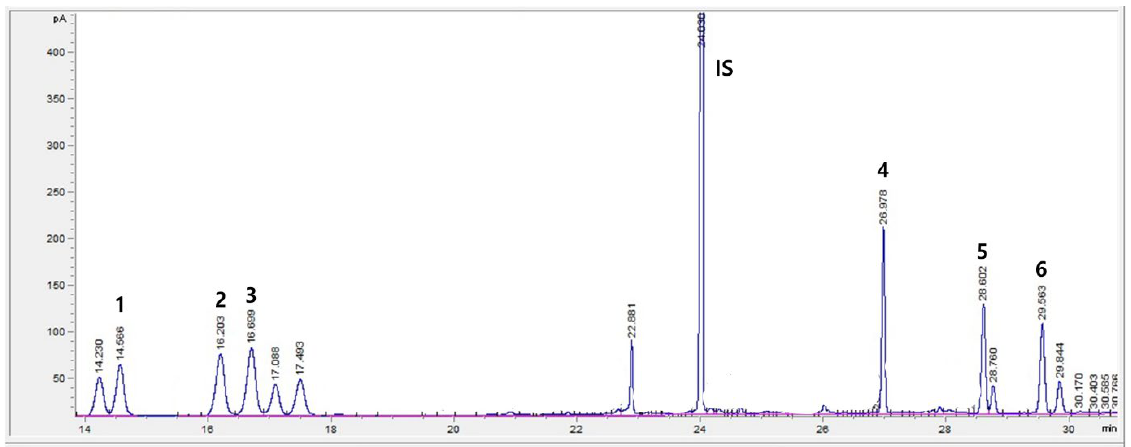
Figure 1. Chromatogram of the separation of six major free sugars by gas chromatography/flame ionization detector (GC/FID). 1 = fructose, 2 = galactose, 3 = glucose, 4 = sucrose, 5 = lactose, 6 = maltose, IS = Internal Standard.